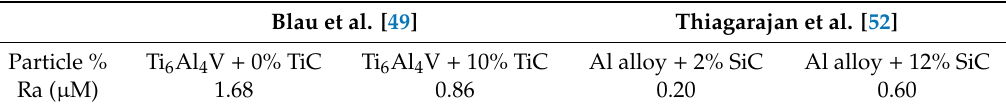
Table 1. E ff ect of particles content on